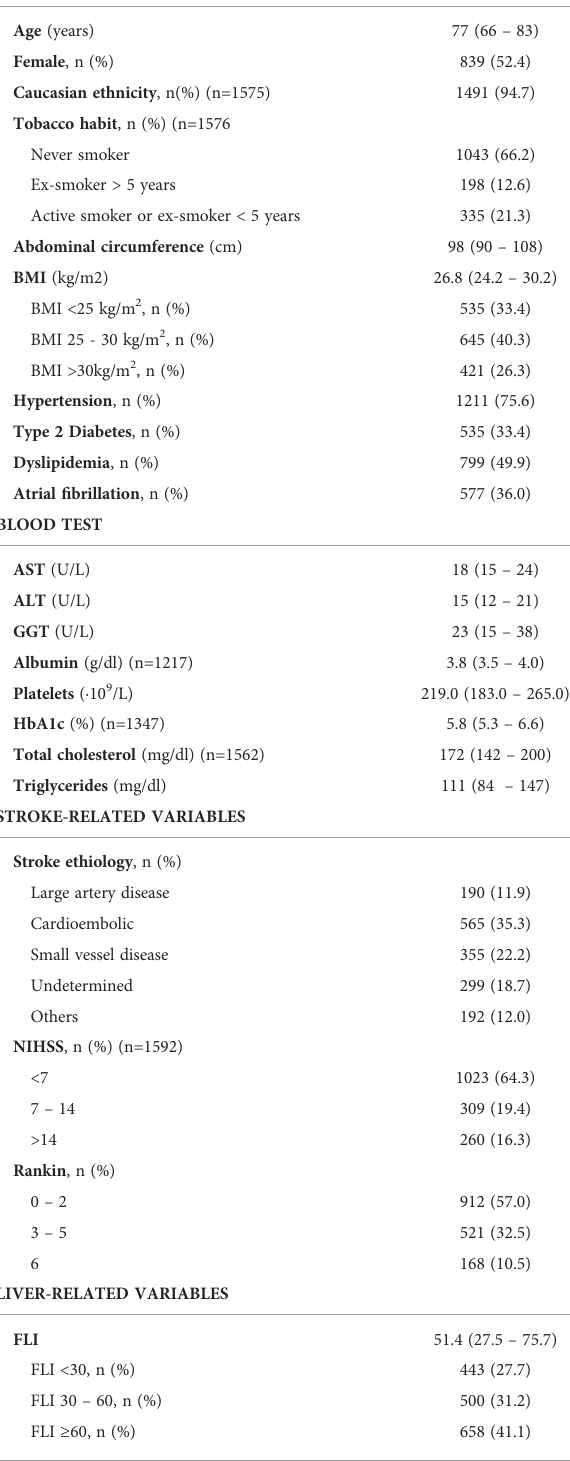
TABLE 1 Basal characteristics of the 1601 patients included in the analysis. Continuous variables are expressed with median (percentile 25 – percentile 75), and categorical variables as count